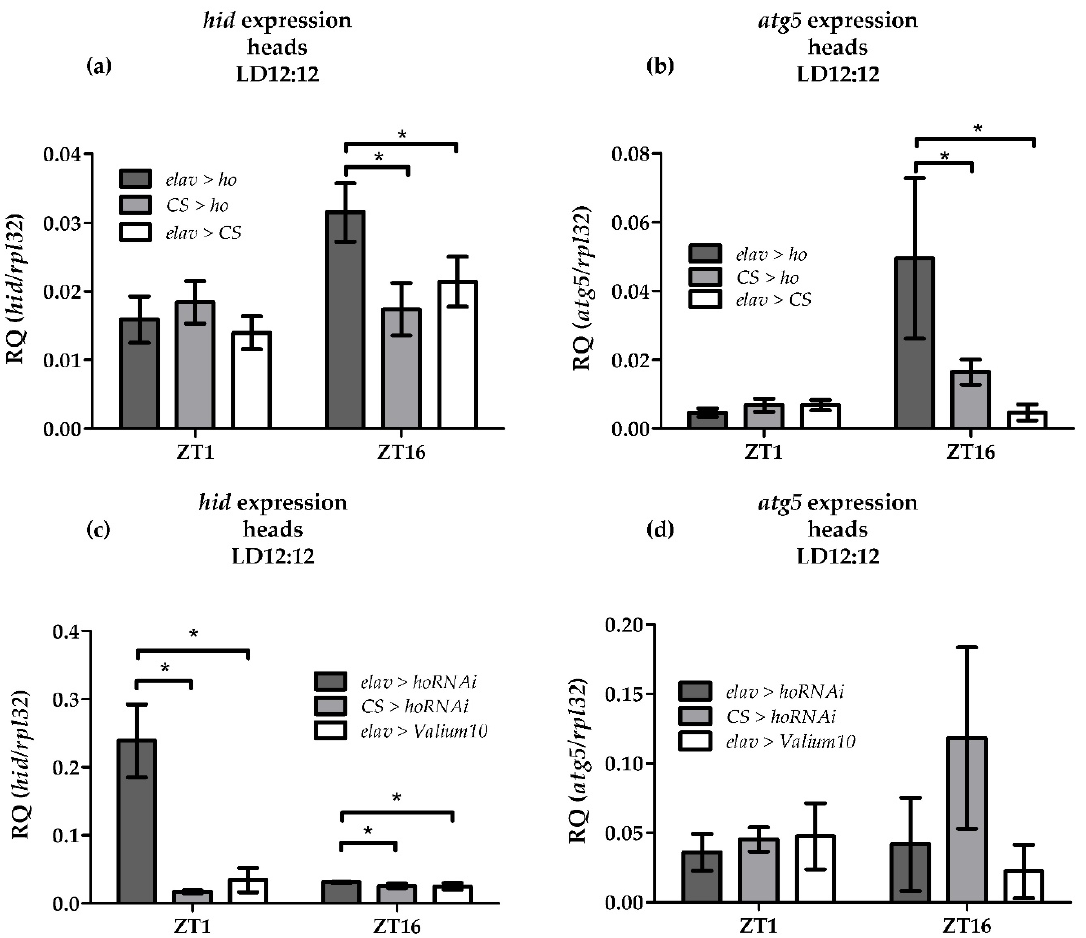
Figure 3. Effects of pan-neuronal overexpression of heme oxygenase ( ho ) on the expression of the apoptosis activator head involution defect ( hid ) ( a ) and autophagy-related 5 (atg5 ) genes ( b ) mRNA at ZT1 and ZT16 as well as the effects of pan-neuronal silencing of ho on the expression of hid ( c ) and atg5 ( d ). Data shown as means ± SD. Statistically significant differences between groups are indicated with asterisks ( elav > ho or elav > hoRNAi vs. controls: p < 0.05).